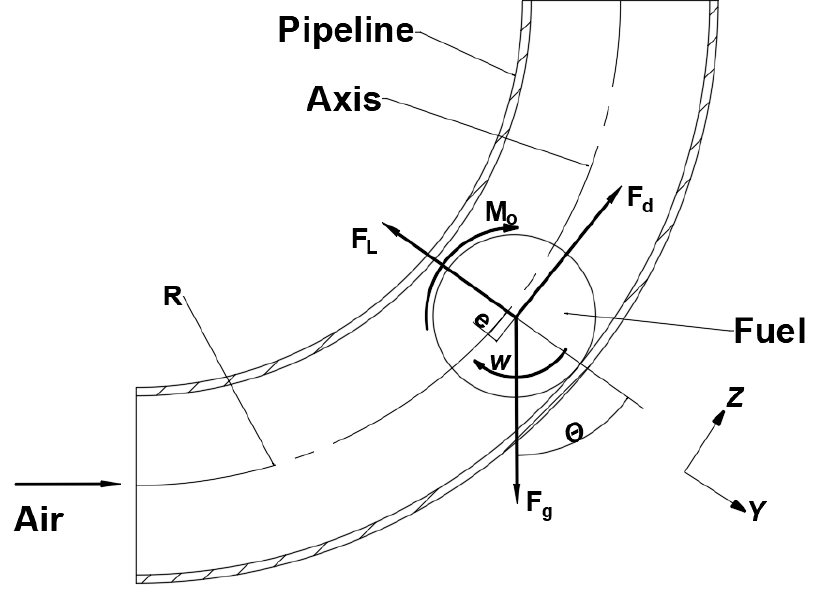
Figure 3. Force on the fuel element in a typical bend. Equations (1)–(3) show the kinetic model of the fuel element in a typical bend based on the basic equations of